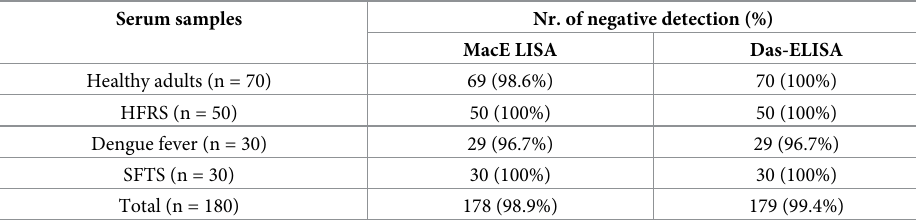
Table 3. Antibody detection in serum samples using Mac-ELISA and